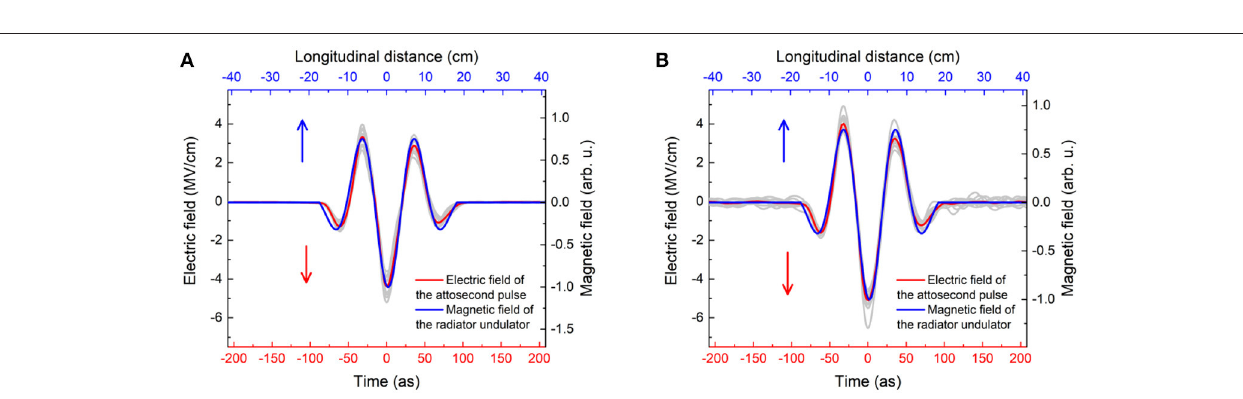
FIGURE 3 | Example of a CEP controlled EUV waveforms for 20nm radiation wavelength (gray) and their average (red) for K = 0.5 and 100pC (A) and 1000pC (B) cases, together with the spatial distribution of the RU magnetic